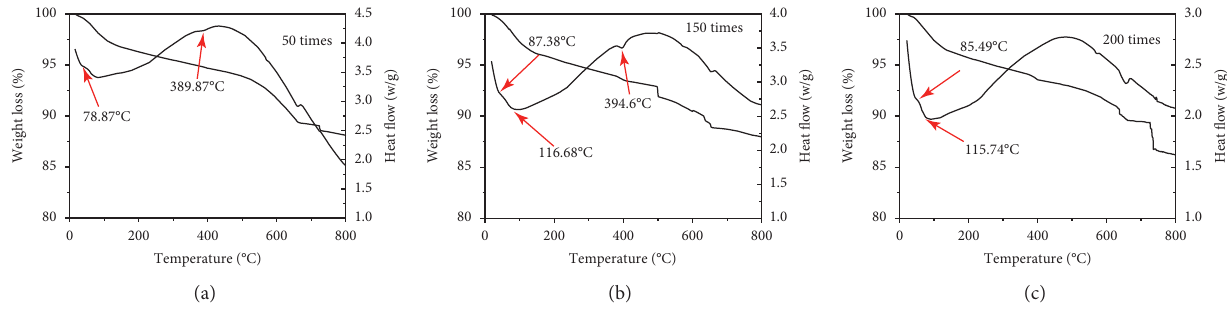
Figure 14: Thermal analysis curves of concrete in sodium sulfate solution after coupling cycles.